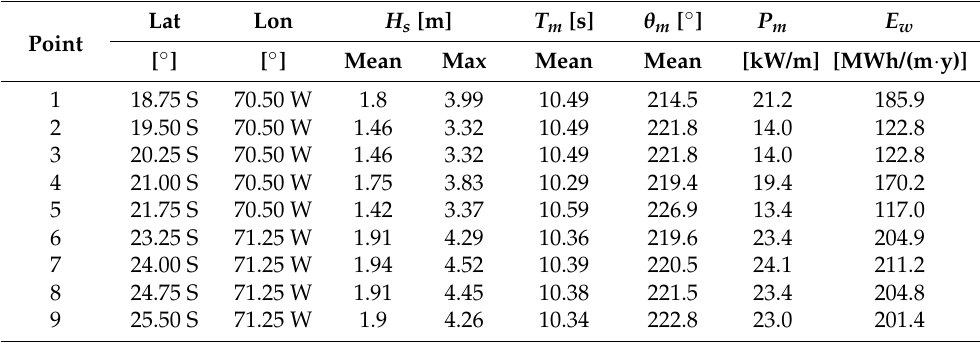
Figure 2. ECMWF grid points along the Chilean coast, with indication of contour lines of the averaged offshore wave power flux per unit of wave-crest length. Table 1. Geographical information, main wave climate parameters, yearly average wave power and wave energy (based on 10-year average) at the ERA-Interim points